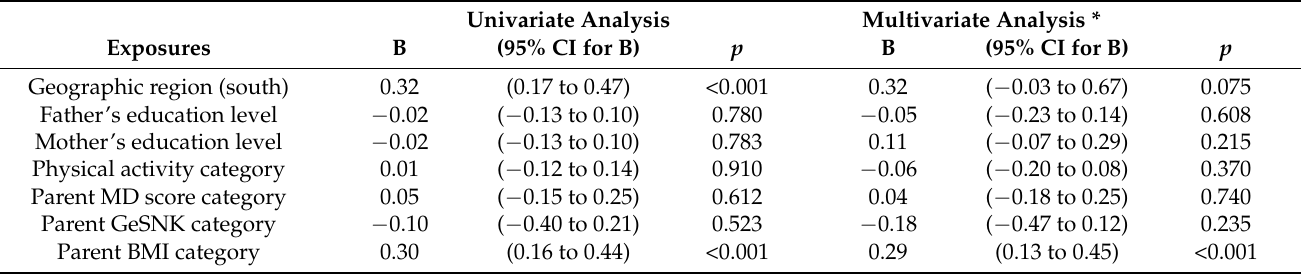
Table 6. Determinants of students’ body mass index category at univariate and multivariate linear regression analysis